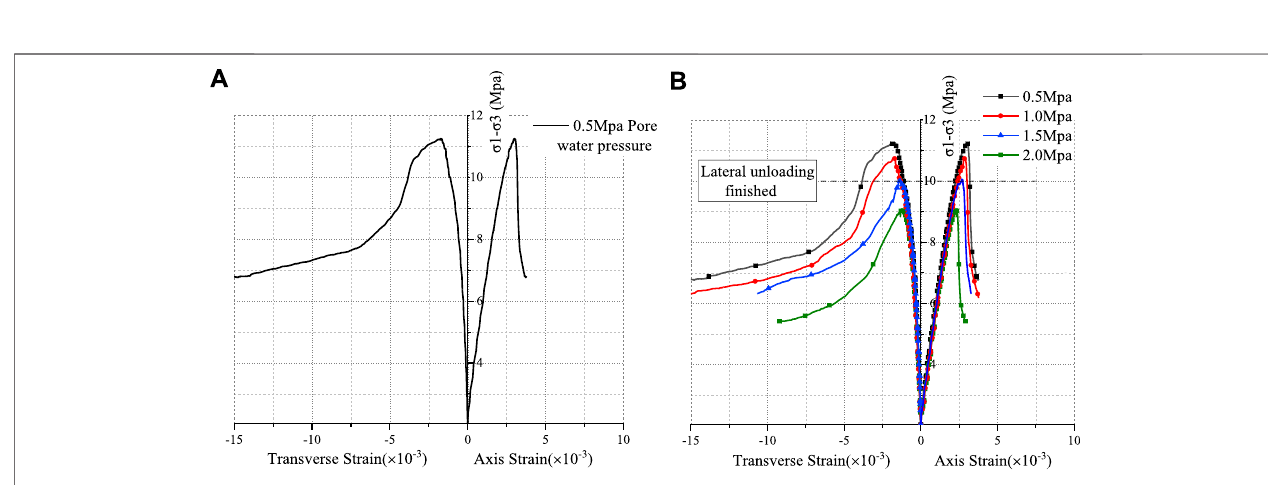
FIGURE 11 | Stress – strain curve under different pore water pressure conditions. (A) Pore water pressure of 0.5 Mpa; (B) comparative curves.